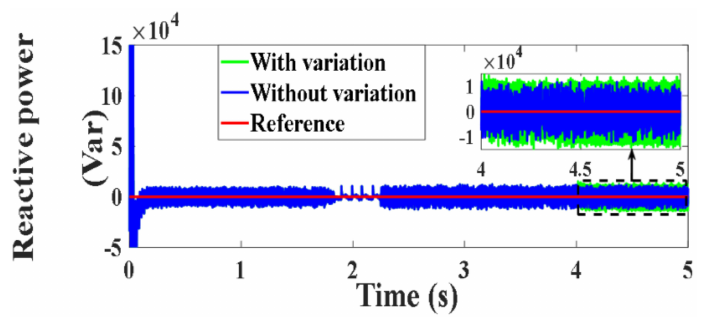
Figure 104. Reactive power under PVC